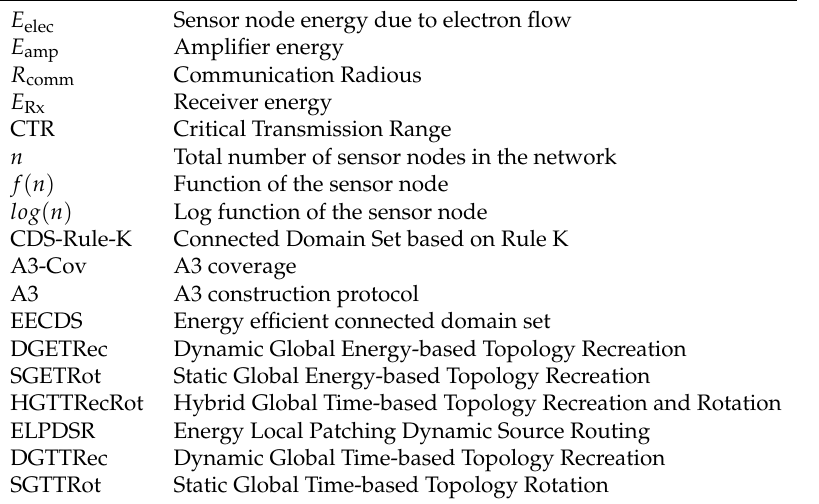
Table 4. Notation and acronyms used in this